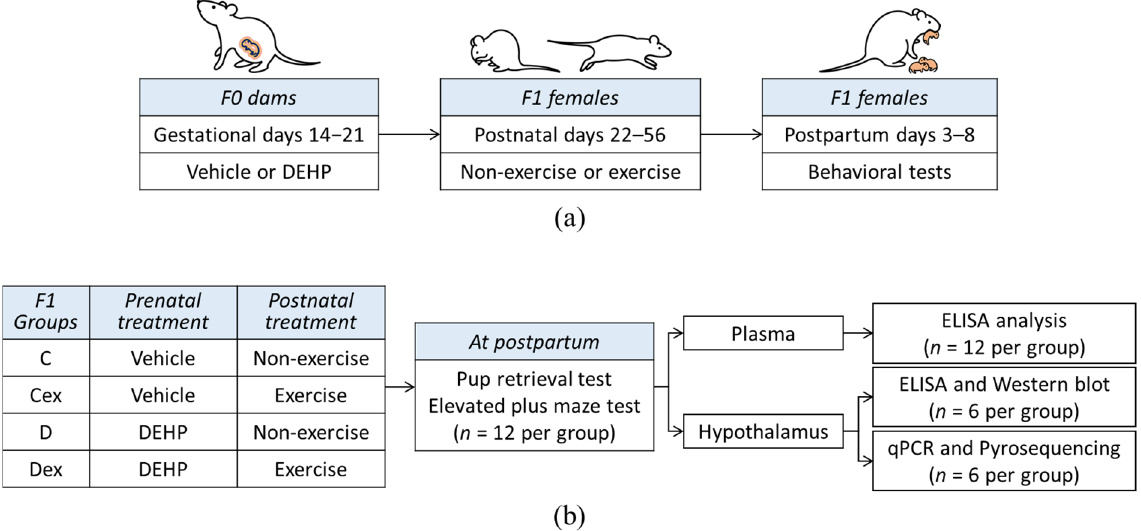
Figure 5. Schematic representation of the experimental design. ( a ) The experimental processes in F0 and F1 generations of dams. ( b ) Second-generation (F1) female rats were divided into four groups: vehicle control (c), exercised vehicle (Cex), DEHP exposure (d), and exercised DEHP exposure (Dex). The performances of maternal behavior and stress response in F1 dams were assessed at the first postpartum week. Biochemical analyses and pyrosequencing were used to evaluate the functions of the oxytocin pathway.